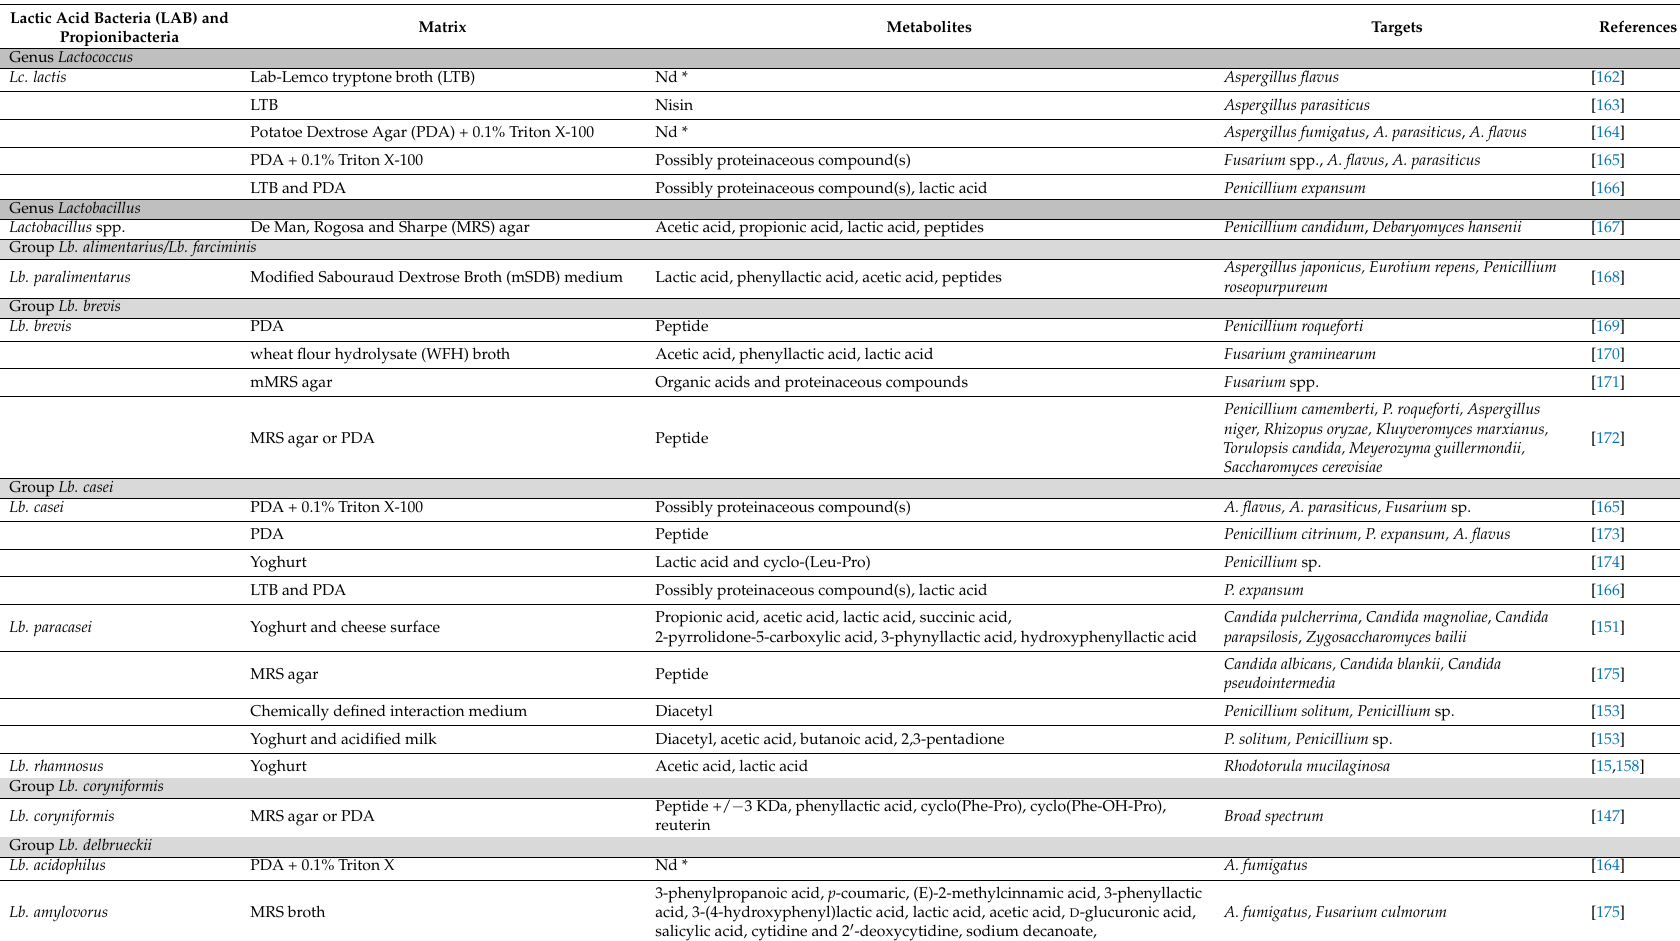
Table 4. Lactic and propionic acid bacteria showing antifungal activities and their responsible